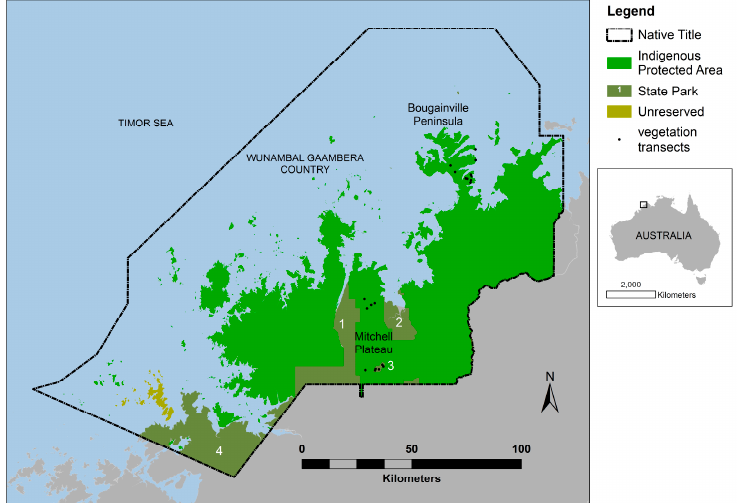
Figure 1. The extent of Wunambal Gaambera country as defined by the Wanjina Wunggurr Uunguu Native Title Determination boundary. The Uunguu Indigenous Protected Area and co-existing State Parks including 1. Mitchell River National Park; 2. Lawley River National Park; 3. Camp Creek Conservation Park; 4. Prince Regent National Park.